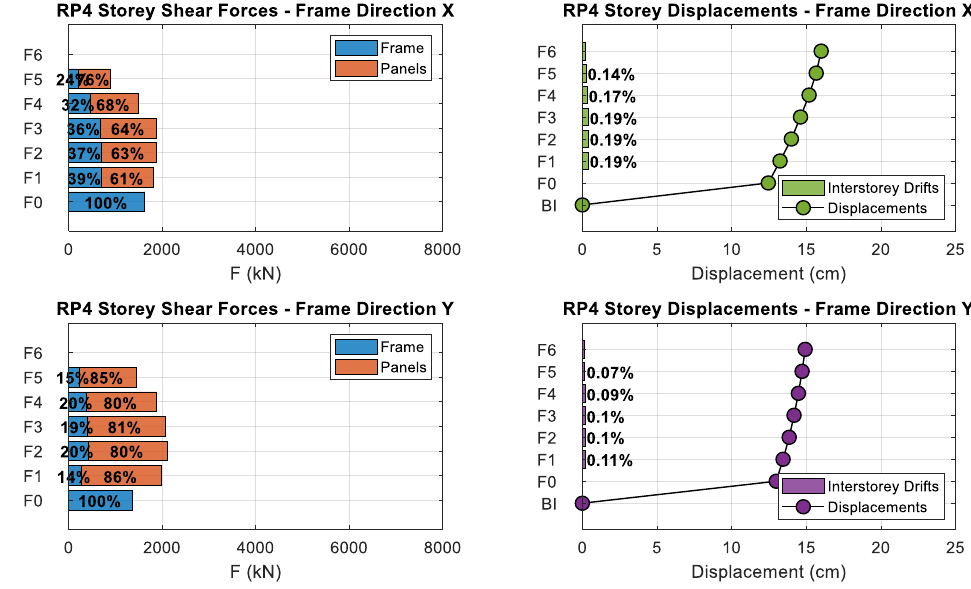
Figure 23. RP4 storey shear forces and displacements.